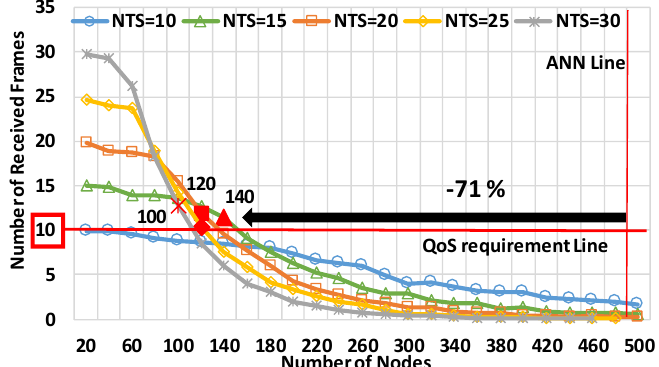
Figure 13. The number of received frames for the number of nodes at the relative speed of 240 km/h in the uniform node distribution model.